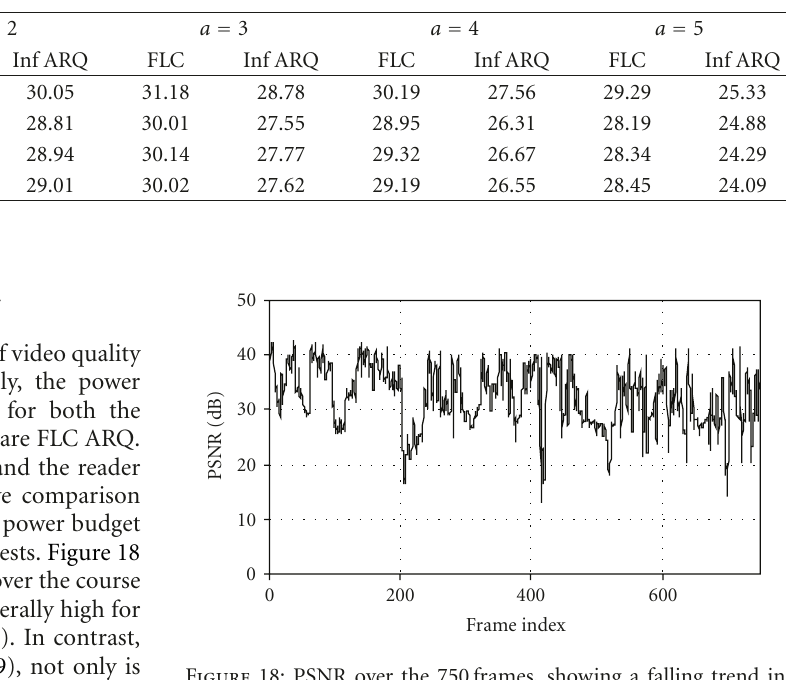
Table 4: Comparison of video quality between power-aware FLC ARQ with DAB, and default ARQ with DAB for various video clips.